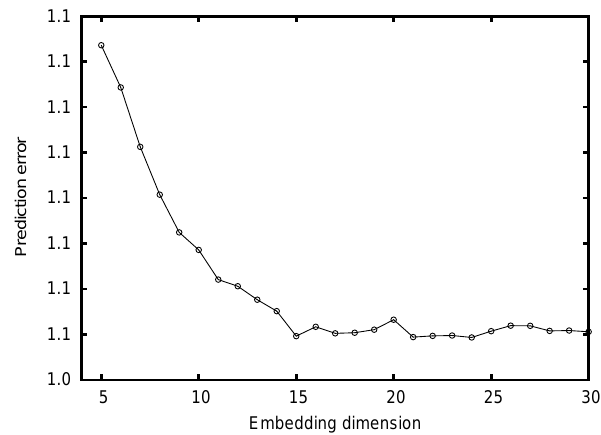
Fig. 17. The plot of the prediction error versus embedding dimen- sion m